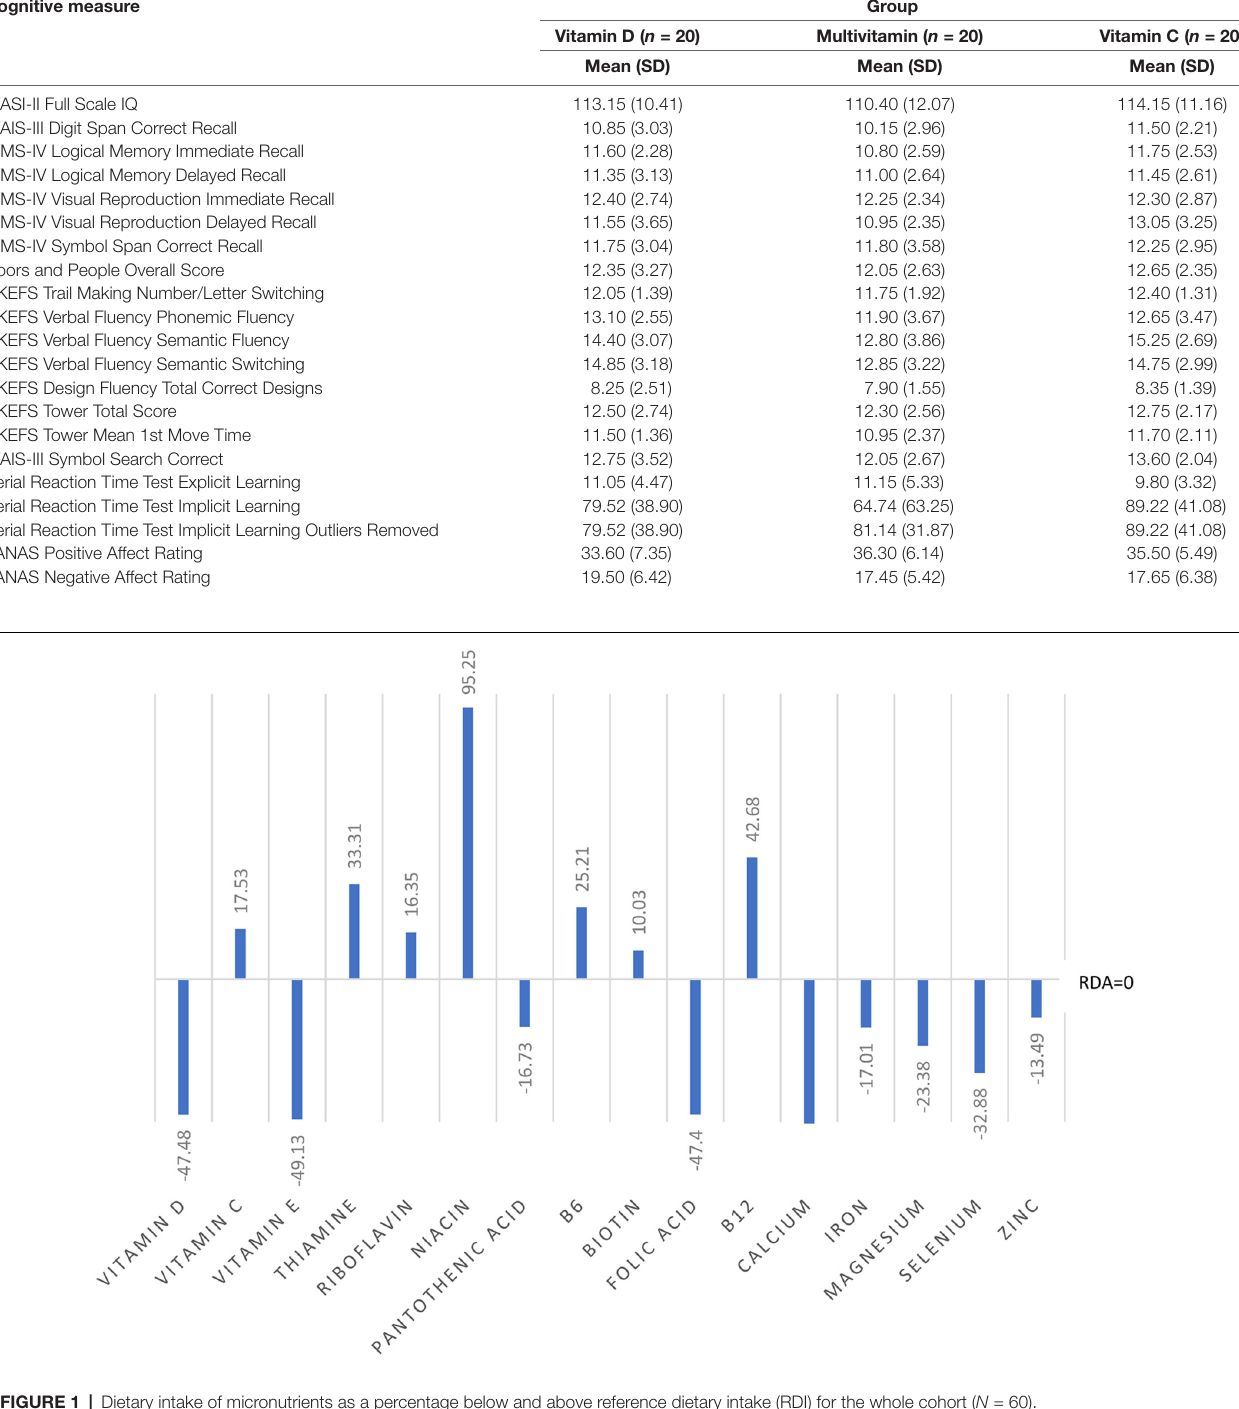
At baseline, the whole group could not be distinguished on the the exception of vitamins C and D, respectively, Vitamin C and Vitamin D, groups showed the same nutritional profile as baseline. Consequently, we analyzed each group’s baseline and post-intervention data